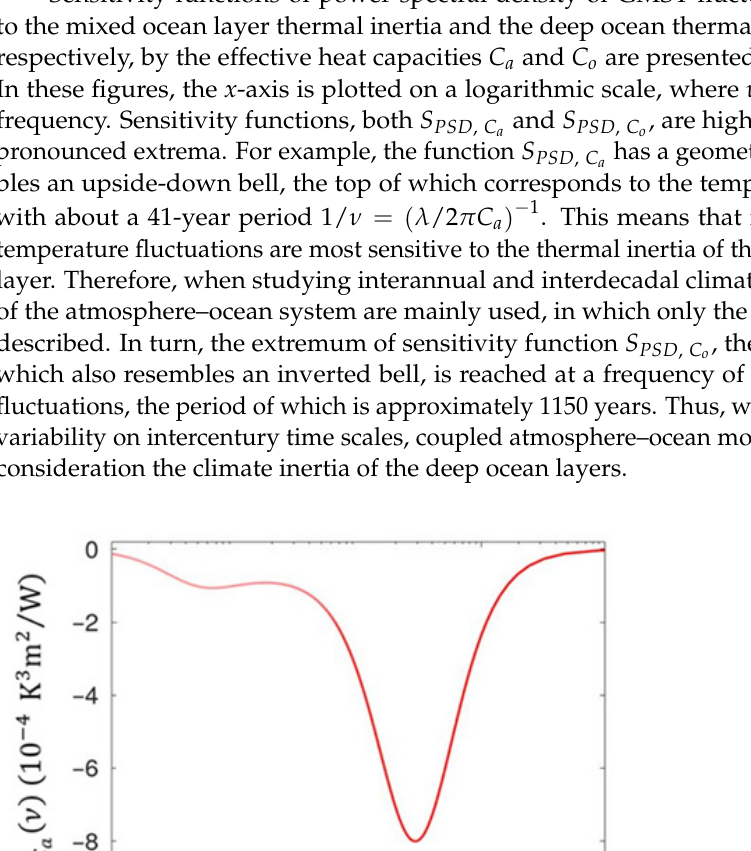
Figure 10. Sensitivity function of power spectral density of the global mean surface temperature fluctuations with respect to the deep ocean thermal inertia, determined by the effective heat capacity 𝐶 (cid:3042) . Sensitivity function of power spectral density of GMST fluctuations with respect to the deep ocean heat uptake 𝑆 (cid:3017)(cid:3020)(cid:3005),(cid:3082) determined by the heat exchange coefficient 𝛾 is illus- trated in Figure 11. This figure shows that climate variability on interannual, decadal, and interdecadal time scales is insignificant. The most sensitive are surface temperature fluc- tuations with about a 170-year period. The sensitivity function 𝑆 (cid:3017)(cid:3020)(cid:3005),(cid:3082) has another extre- mum corresponding to surface temperature fluctuations, the period of which is about 2250 years. However, in absolute value, this extremum is about four times less than the first one.